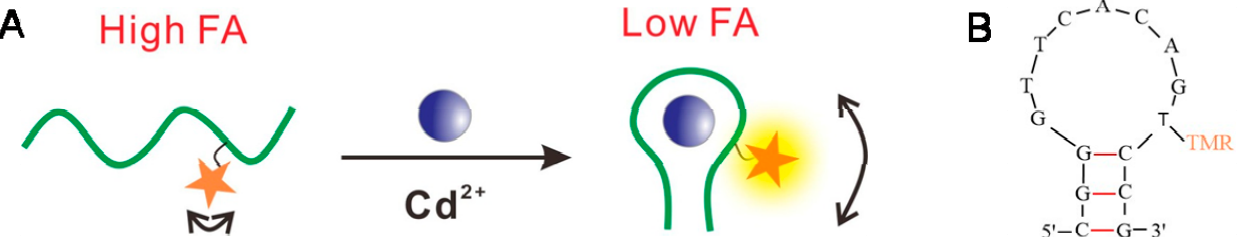
Figure 1. ( A ) Schematic diagram of fluorescence anisotropy sensor for Cd 2+ using TMR-labeled aptamers. ( B ) The predicted secondary structure of the aptamer CBA15, with single TMR labeled on the 12th thymine base.